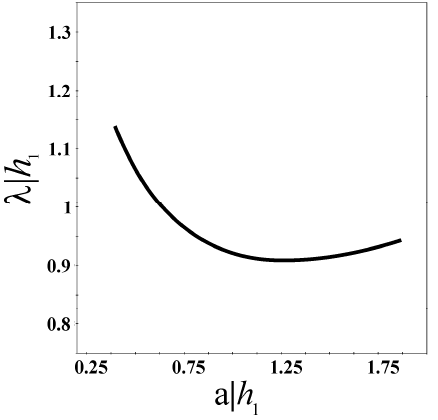
Fig. 13. Wave speed C versus amplitude of solitary waves of de- Figure 13. Wave sped c versus amplitude a of solitary waves of depression for 2 / 1 = 1.022, 3 pression for ρ 2 /ρ 1 = 1 . 022, h 1 /h 2 = 10 / 61 . h